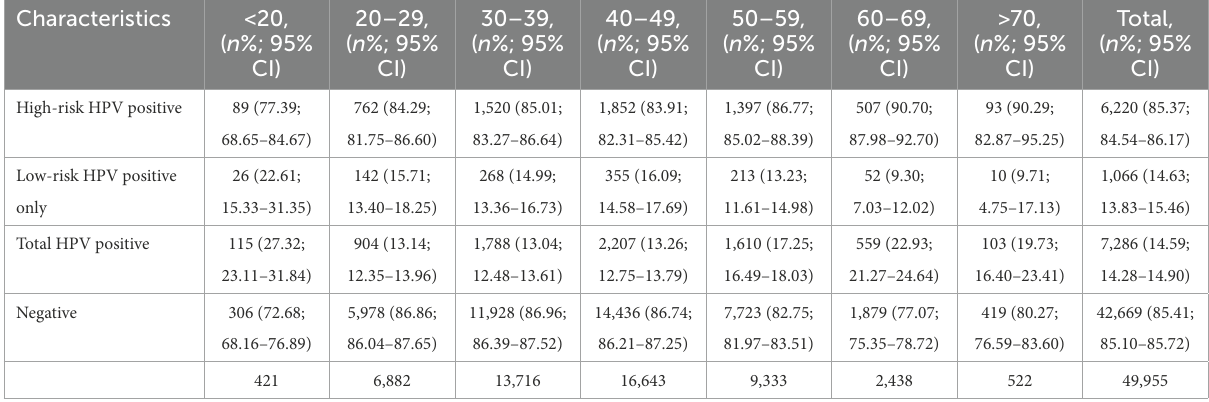
TABLE 1 HPV prevalence in different age